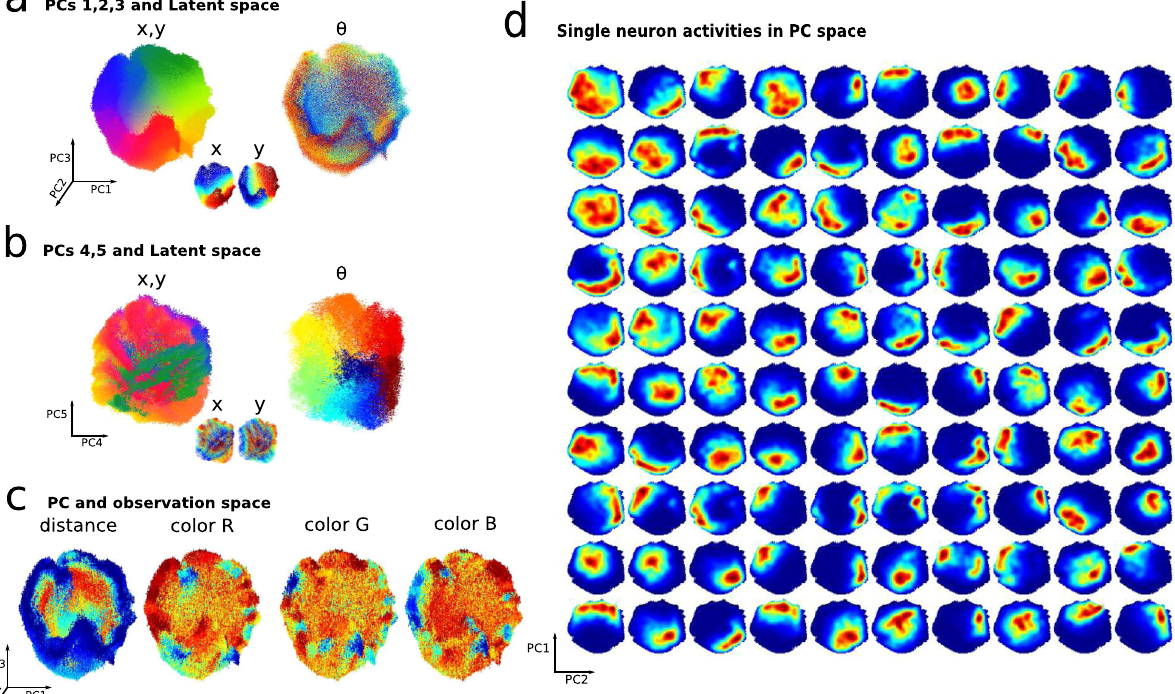
Fig. 5 Features of the learned predictive representation. a 100,000 points of the neural network representation, corresponding to an equal number of steps for the agent ’ s exploration, are shown projected into the space spanned by PCs 1 to 3 of the learned representation, and colored, respectively, according to x , y latent variables (cfr. Fig. 1a for color code) and θ . b Same as panel b but for PCs 4 and 5. c Same as panel a but colored with respect to the mean distance or color activations of the agent ’ s sensors. In this speci fi c example, the fi rst fi ve PC components explain, respectively, 13.7%, 11.4%, 10.2%, 5.5%,5.4% of the total neural variance. d Manifold cell activations: average activity of 100 neurons on the manifold (here displayed for the fi rst PCs 1 and 2.). The activity of each neuron (one per quadrant) is averaged as the population activity is in a speci fi c “ location ’’ on the neural manifold in the space spanned by PCs 1 and